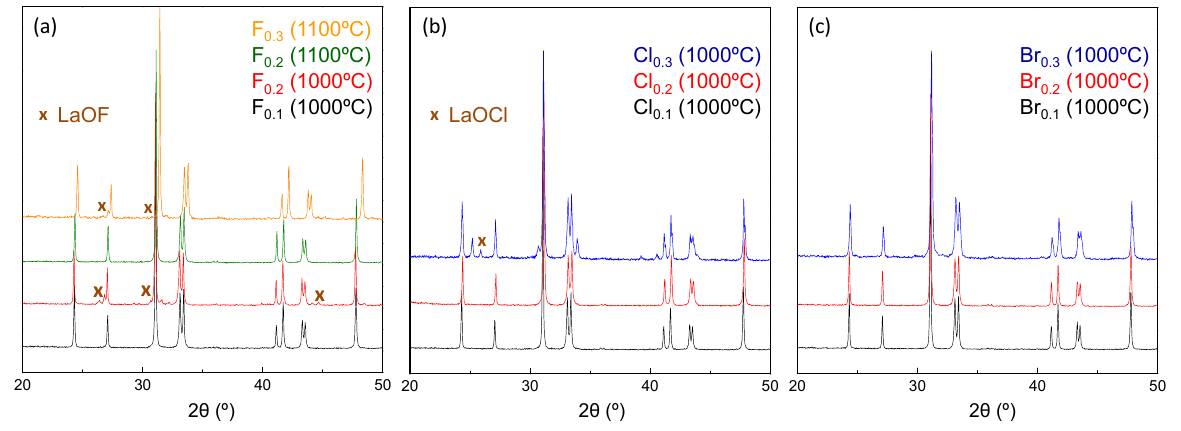
Figure 2. XRPD patterns of ( a ) La 2 CuO 4 − 0.5x F x (x = 0–0.3), ( b ) La 2 CuO 4 − 0.5x Cl x (x = 0–0.3) and ( c ) La 2 CuO 4 − 0.5x Br x (x = 0–0.3), sintered at 1000 and 1100 °C for 1 h.